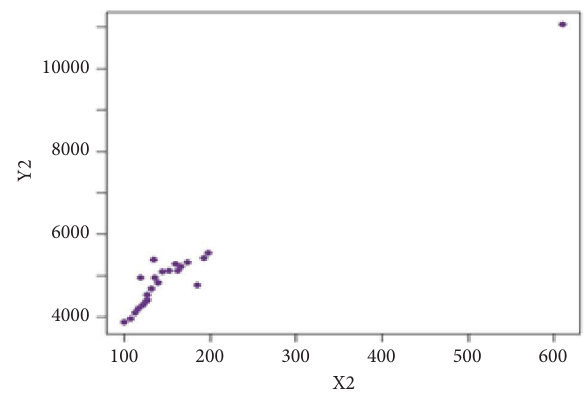
Figure 2: Stratum-II (population-1).